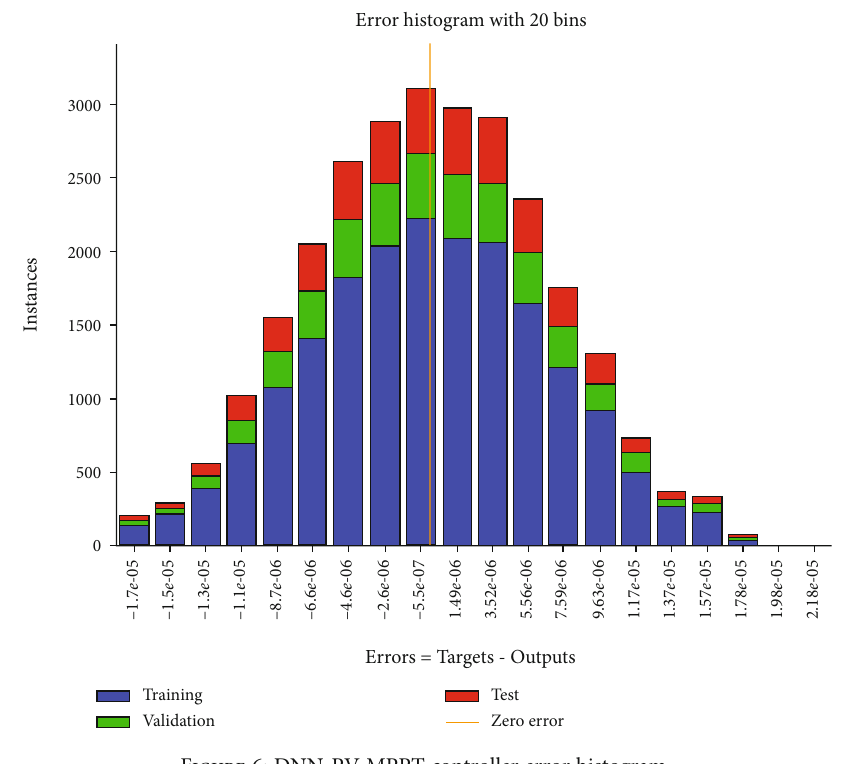
Figure 6: DNN-PV MPPT controller error histogram.